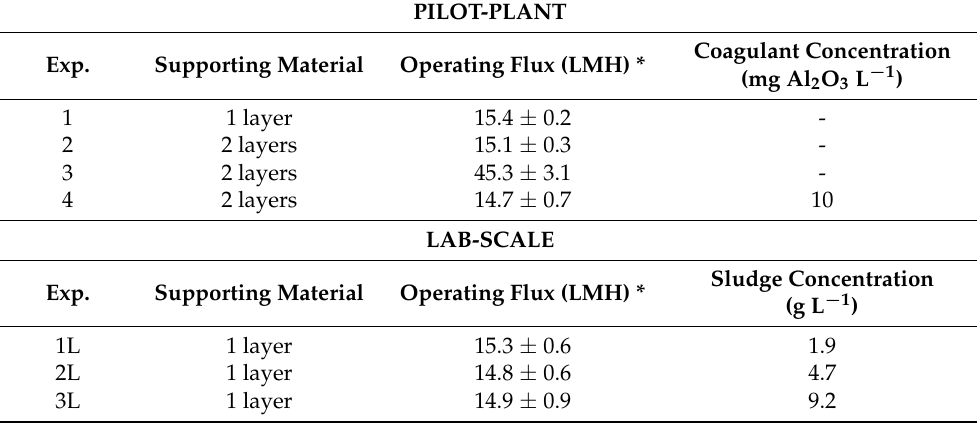
Table 2. Experimental